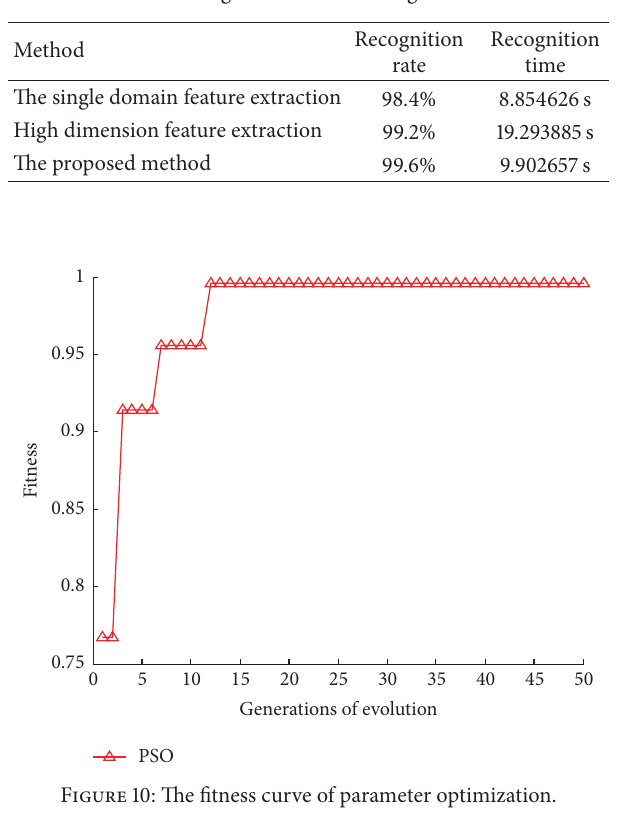
Table 3: Recognition rate and recognition time.